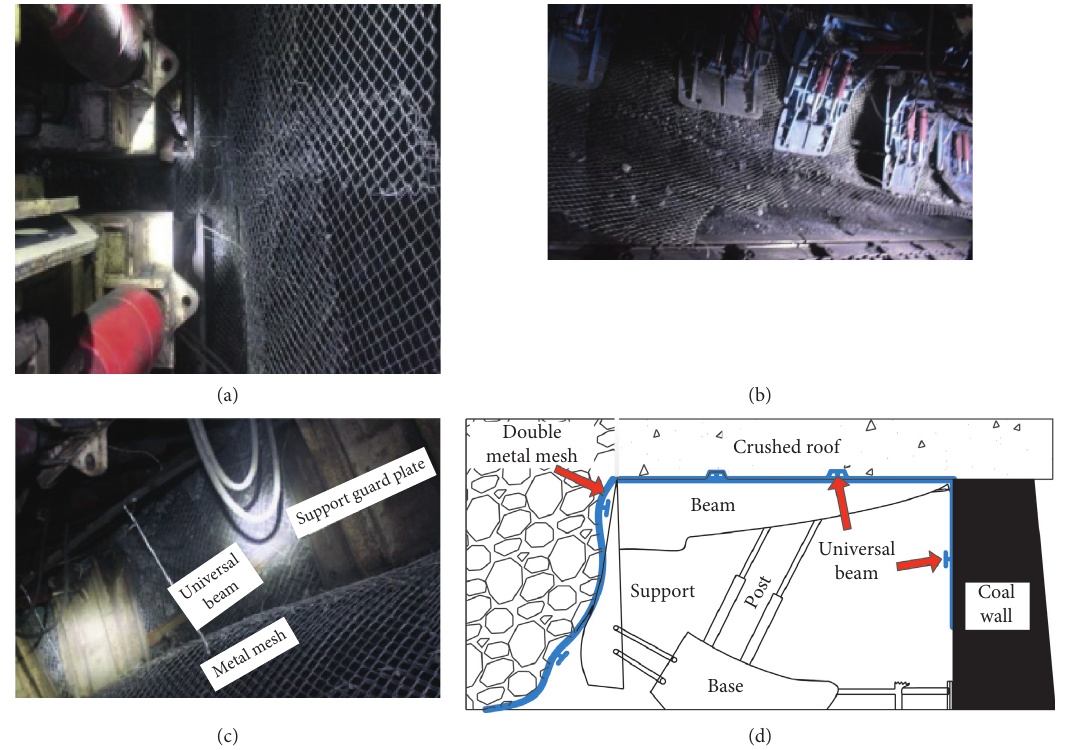
Figure 19: The support enhancement program for the coal wall and roof. (a) Double metal mesh on support. (b) Enlarged guard plate. (c) Support with guard plate, metal mesh, and universal beam. (d) Section of coalface.